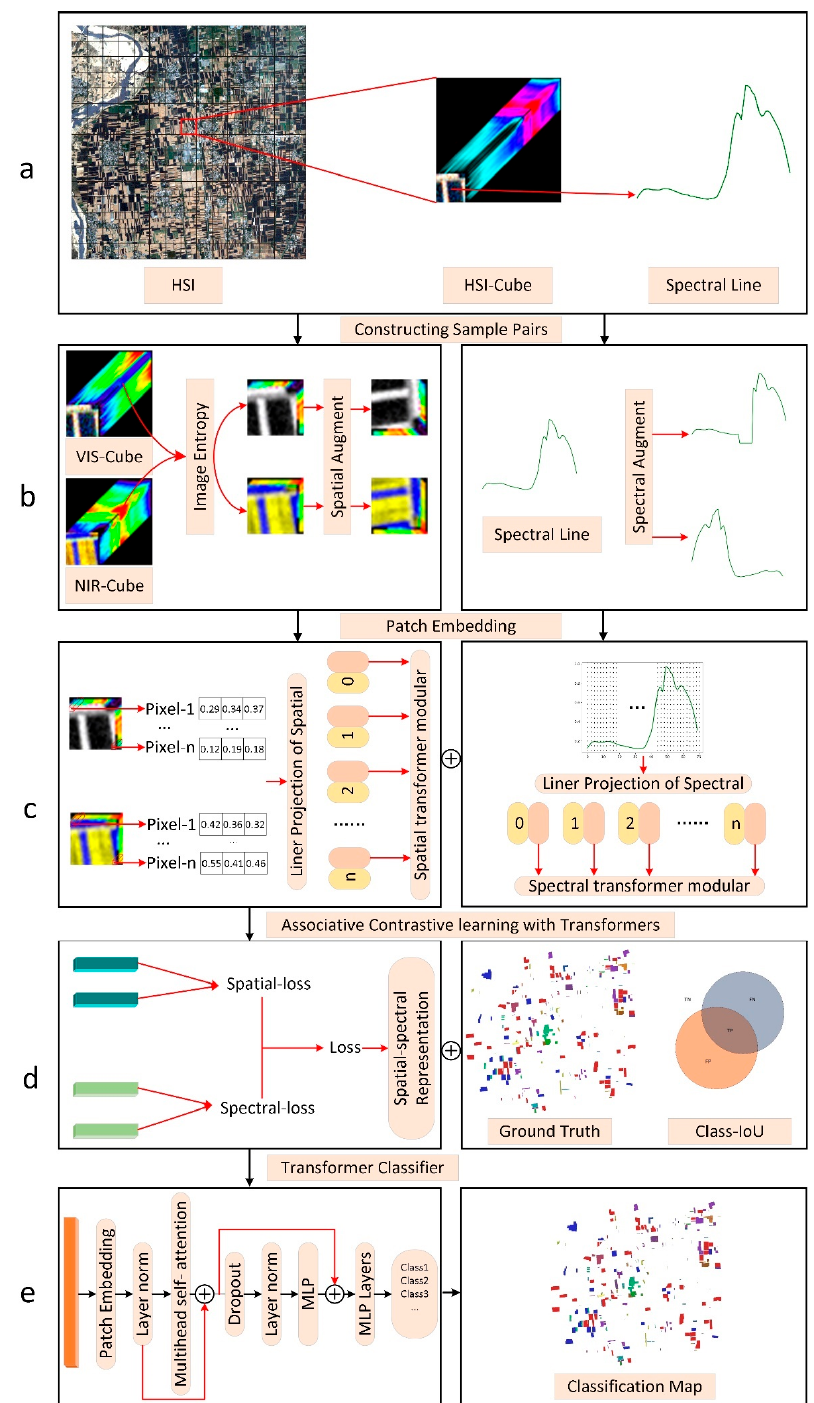
Figure 3. Workflow of the proposed method. ( a ) Generate data cube patches. ( b ) Image entropy and data augmentation. ( c ) Spatial and spectral patch embeddings. ( d ) Spatial-spectral associative contrastive learning and Class-IoU. ( e ) HSI